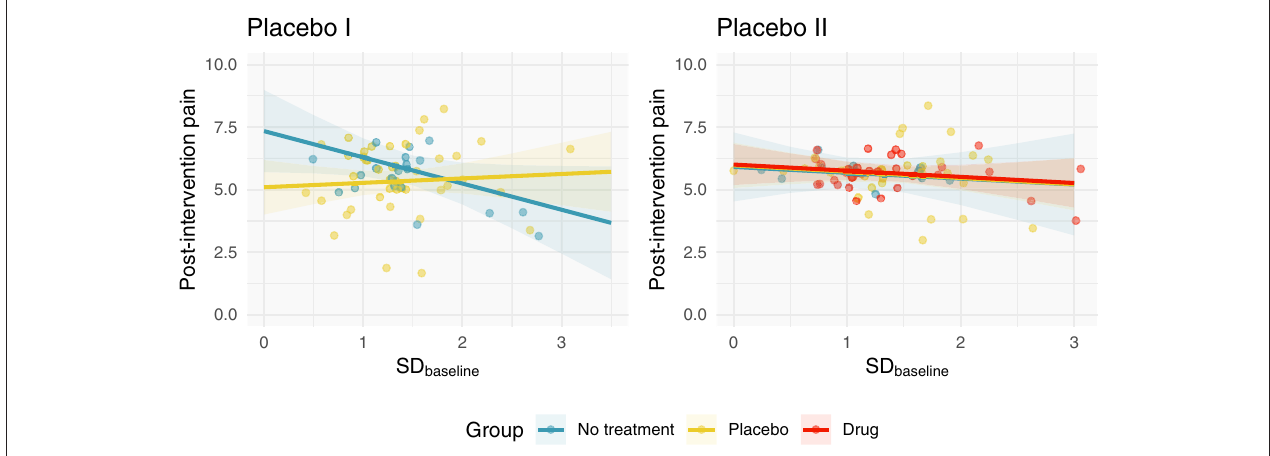
FIGURE 1 | Adjusted post-intervention pain as a function of SD baseline and group. We fit a linear regression to each study, which modeled post-intervention pain as a function of pre-intervention pain, SD baseline , and group. Here, we depict the relationship between SD baseline and post-intervention pain after adjusting for pre-intervention pain. In Placebo I, the no treatment group has a weak negative correlation; the placebo group’s SD baseline is not correlated with post-intervention pain. In Placebo II, all groups demonstrate negligible correlations with SD baseline .